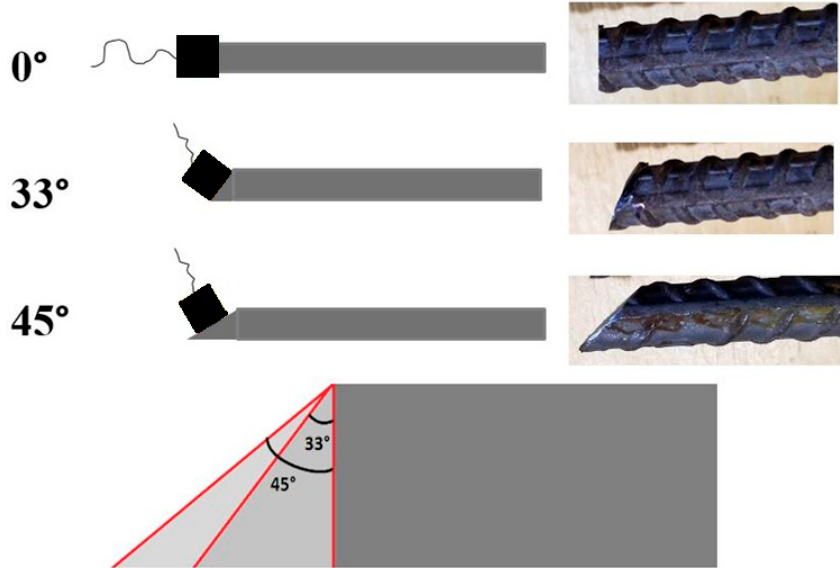
Figure 8. Bar end Figure 8. Bar end angles. Figure 8. Bar end angles.